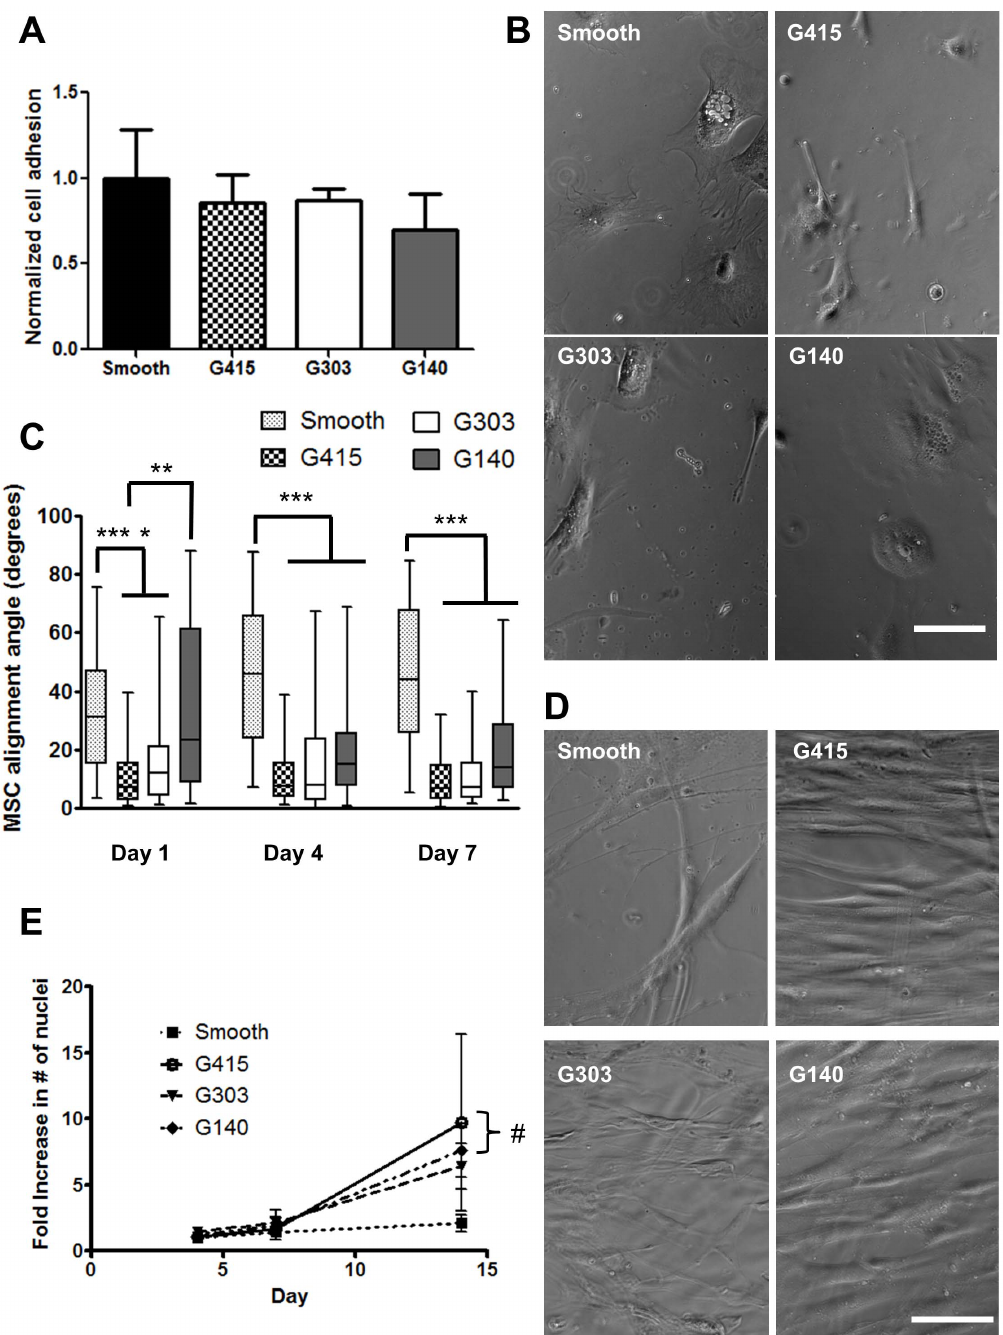
Figure 4. Nanotopography modulated MSC alignment and proliferation but did not modulate initial adhesion. (A) Similar numbers of MSCs adhered to all PMMA surfaces after four hours as quantified by DAPI stained cells. (B) Phase contrast images illustrate that cell adhesion was similar on all PMMA surfaces after four hours. Scale bar represents 100 m m. (C) Quantification of MSC alignment revealed significantly more MSC alignment (denoted by alignment angles closer to 0 u , parallel to the underlying topography) on G415 and G303 substrates relative to smooth PMMA at all times points. Significant differences in alignment were also observed on G140 substrates (relative to smooth PMMA) at day 4 and 7. Data are plotted in a box and whiskers format, with the horizontal bars representing the medians, the boxes denoting the 25th and 75th confidence intervals of the data, and the whiskers denoting the boundaries of the 5th and 95th intervals. A minimum of 36 cells were analyzed for each of the conditions at each time point (nearly all the data sets were non-normally distributed, hence Kruskal-Wallis analysis was used, see Materials and Methods). (D) MSCs cultured on patterned PMMA aligned parallel to the direction of the nanotopography, as shown in these representative images following 14 days of culture. Scale bar represents 100 m m. (E) MSCs grown on G415 (p , 0.005) and G140 (p , 0.05) substrates proliferated at statistically greater rates compared to smooth PMMA after 14 days. Error bars represent standard deviation, n=3 for day 4, 7 and n=5 for day 14 (* p , 0.05, ** p , 0.01 , *** p , 0.005).